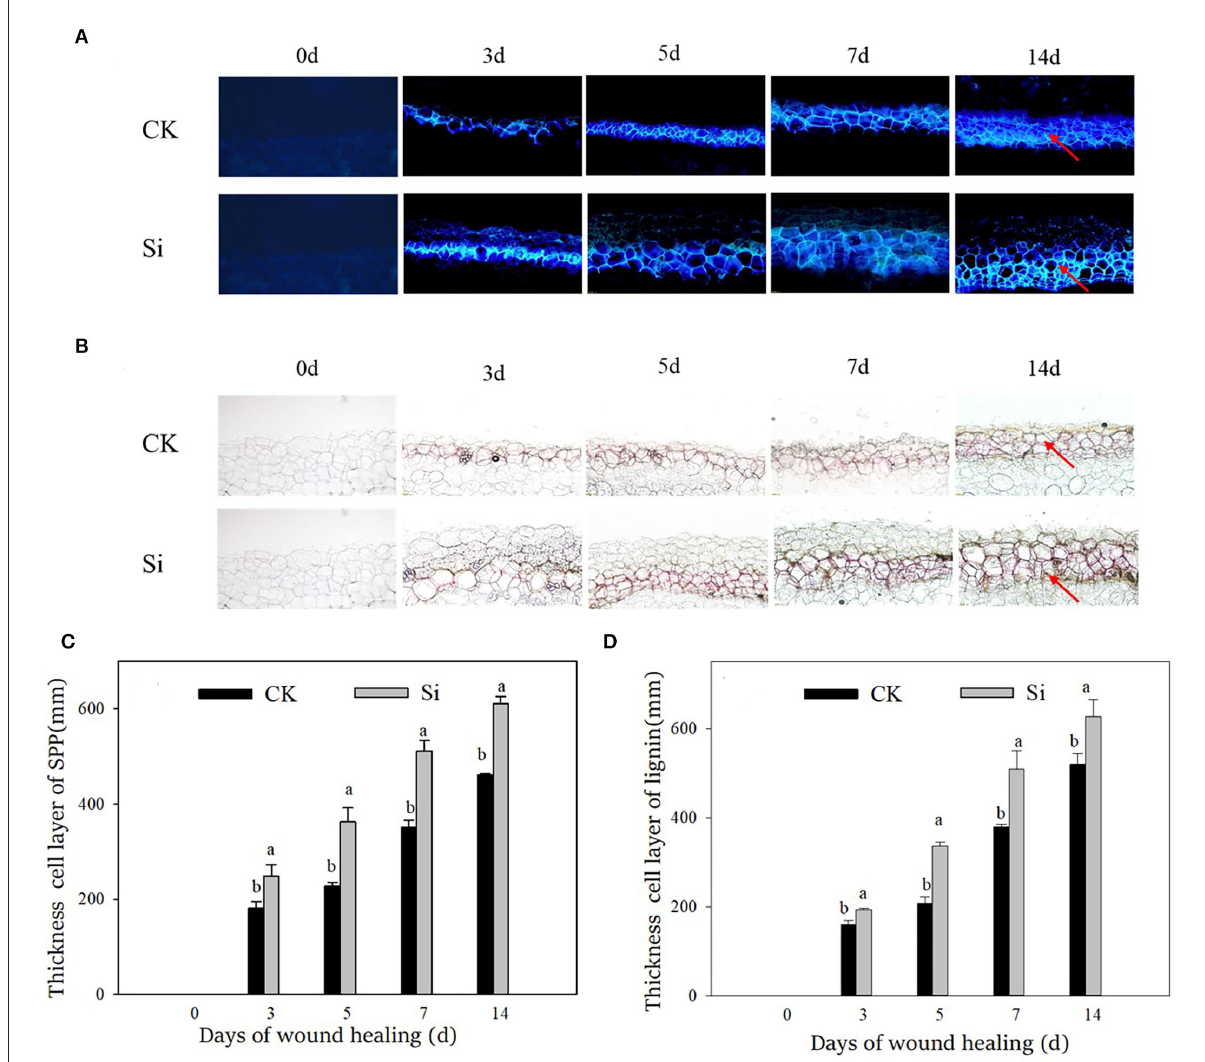
FIGURE2 Effect of sodium silicate treatment on the accumulation and cell layer thickness of SPP and lignin during healing. (A) Accumulation of SPP. (B) Accumulation of lignin. (C) Cell layer thickness of SPP. (D) Cell layer thickness of lignin. Red arrows represent the accumulation site of SPP and lignin. Vertical bars indicate the standard error of three replicate assays. Columns with different letters at each time point are significantly different (LSD, P < 0.05).